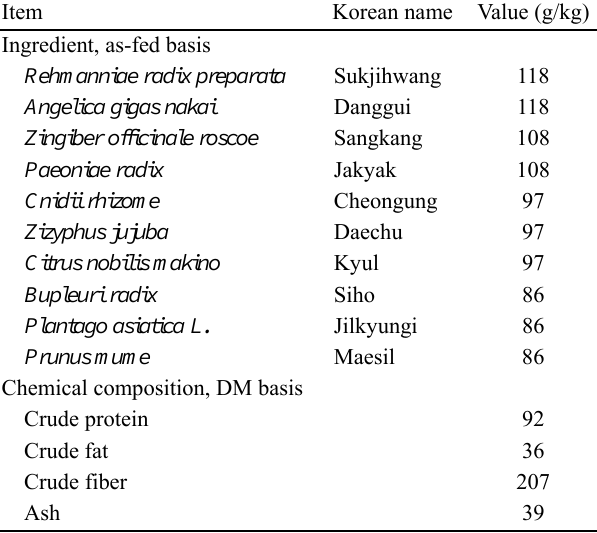
Table 2. Ingredient and chemical compositions of medicinal plant